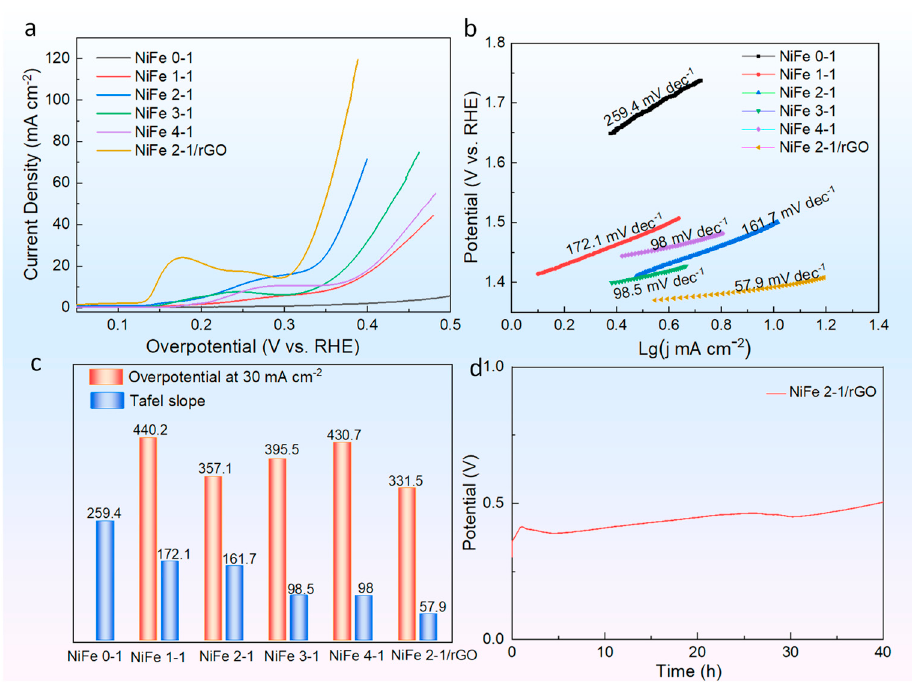
Figure 3. Electrochemical measurement of PBA materials. ( a ) LSV curves; ( b ) linearly fitted Tafel slope; ( c ) histogram of overpotential and Tafel slope values; ( d ) the durability of PBA NiFe 2-1/rGO composite at the current density of 30 mA cm − 2 .